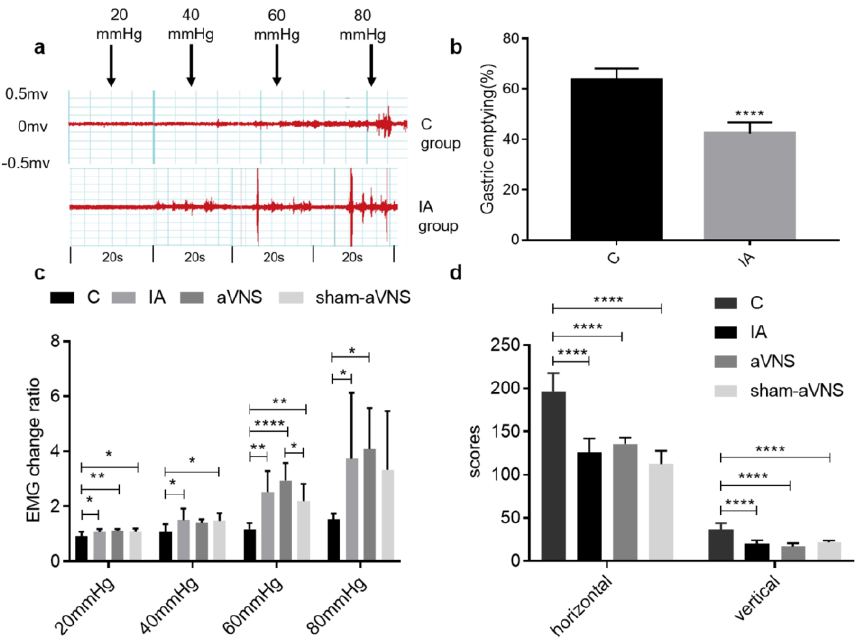
Figure 2. Assessment of rat model. ( a ) Different EMG waveforms changes response to gastric distension (GD) of 20, 40, 60 and 80 mmHg in control rats and IA-treated rats. ( b ) Gastric emptying results in control rats and IA-treated rats. The index was detected from 12 sacrificed rats after the 9th week (6 rats were randomly picked in control group and IA-treated group, respectively). The independent sample t-test was used. ( c ) EMG change ratio response to GD in all rats when rat model was induced. ( d ) The open field test (OFT) results when rat model was induced in all rats. All indexes were tested after the 9th week and before aVNS or sham-aVNS. One-way ANOVA was used, and the LSD method was used for post hoc tests in EMG change ratio and OFT. EMG: electromyography. * p < 0.05, ** p < 0.01, **** p < 0.0001. C: control group; IA: IA-treated group. n = 6 per group. Data were presented as means ± standard